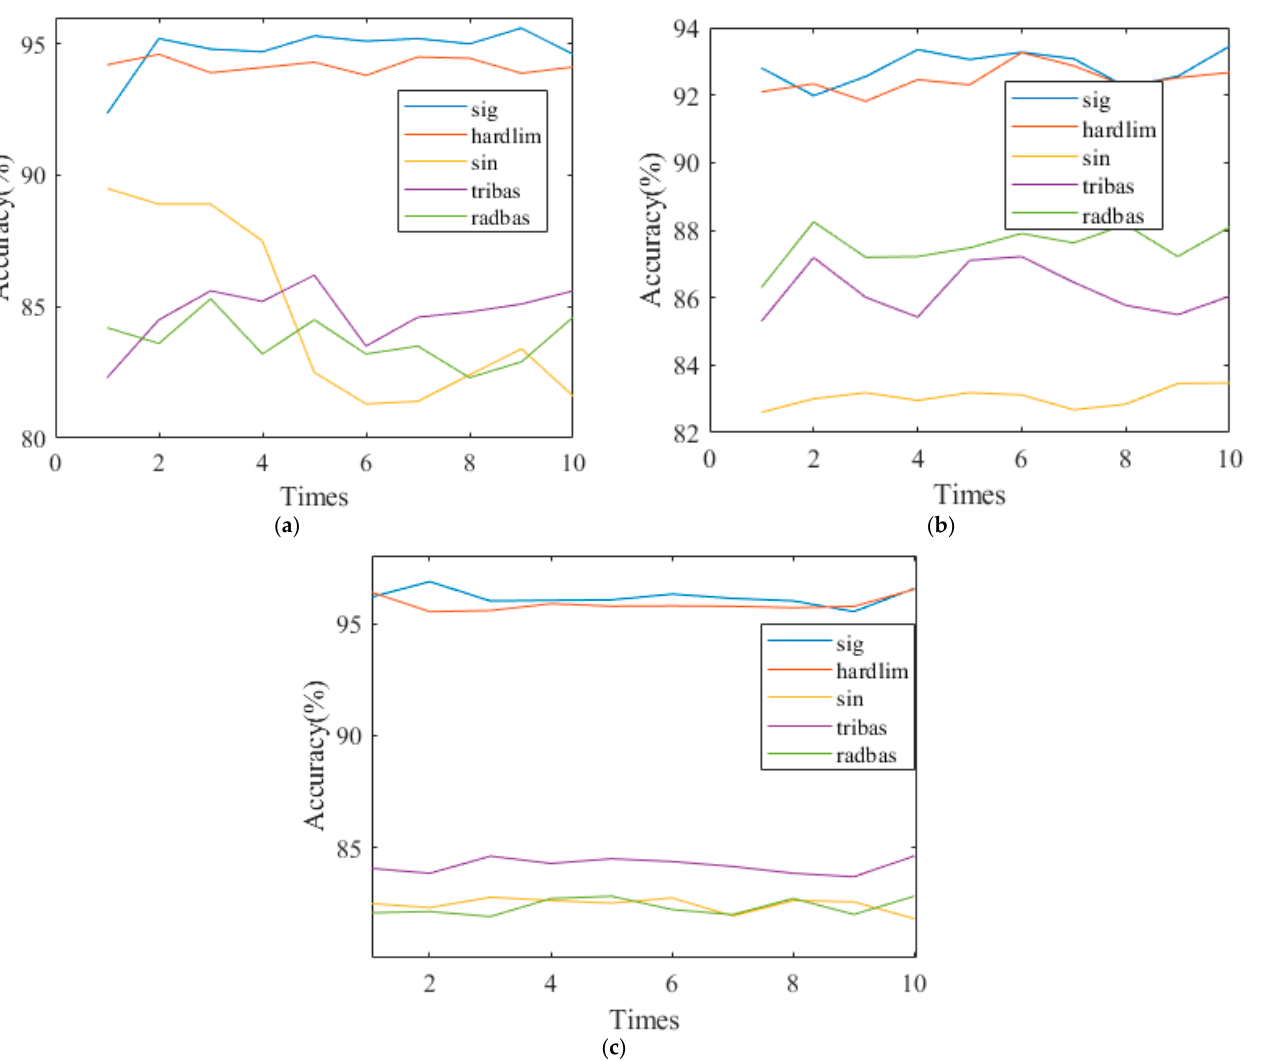
Figure 9. Influence of IAOS parameters on algorithm performance. From Figure 9, we can find that the model’s prediction accuracy rises with the number in the population and the number of iterations. The higher the number of particles randomly distributed in the search range, the better the search ability and the higher the model output accuracy. At the same time, as the number of iterations of the model increases, the more mature the structure of the model becomes, and the higher and smoother the prediction accuracy becomes. At the same time, the number of particles is not as high as it should be. For an algorithm, an increase in the number of particles also means an increase in the amount of computation. Losing a large amount of computation to obtain higher accuracy is not worth the cost. The same holds true for the number of